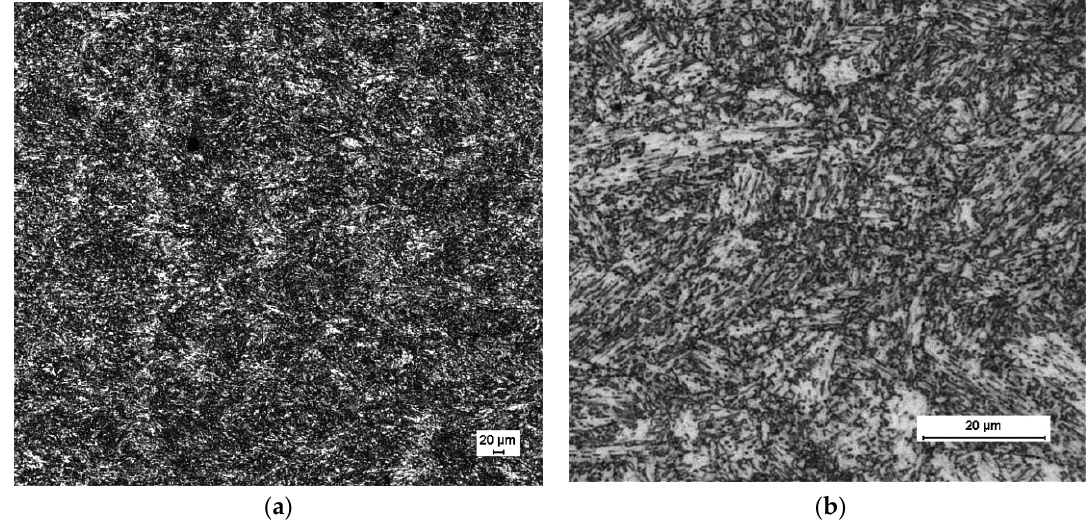
Figure 6. SEM investigation of the surface of an SLM manufactured part (insert). ( a ) Magnification at 50×; ( b ) magnification at 500×. Image courtesy of voestalpine group. 50 × ; ( b ) magnification at 500 × . Image courtesy of voestalpine